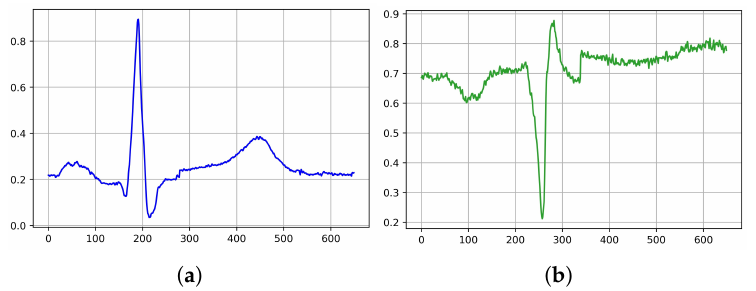
Figure 4. Illustration of original ECG signal: ( a ) normal sinus rhythm, ( b ) myocardial infarction sinus